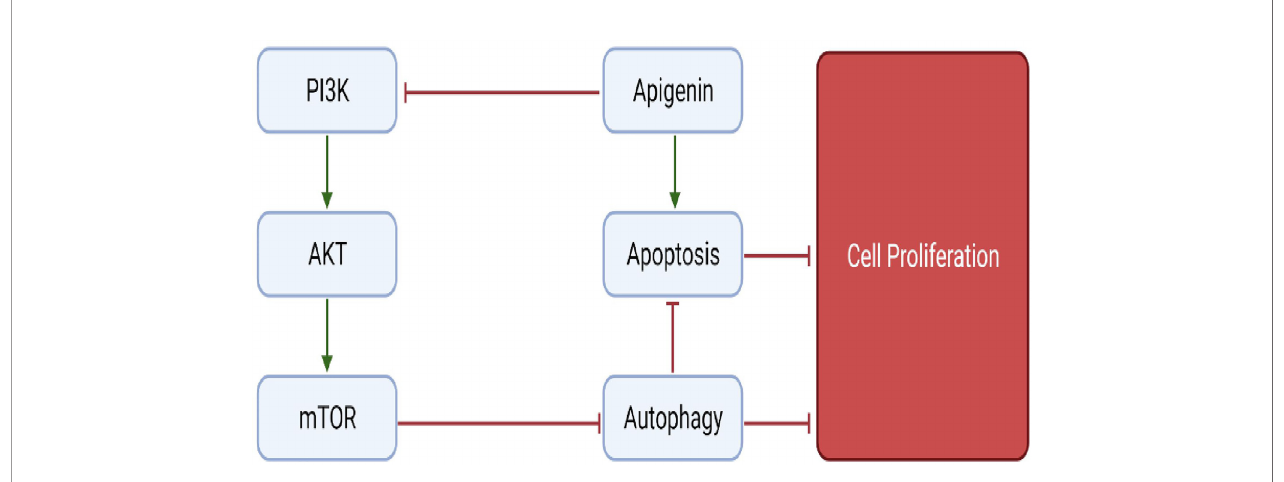
FIGURE 8 | Regulation of autophagy and apoptotic pathways